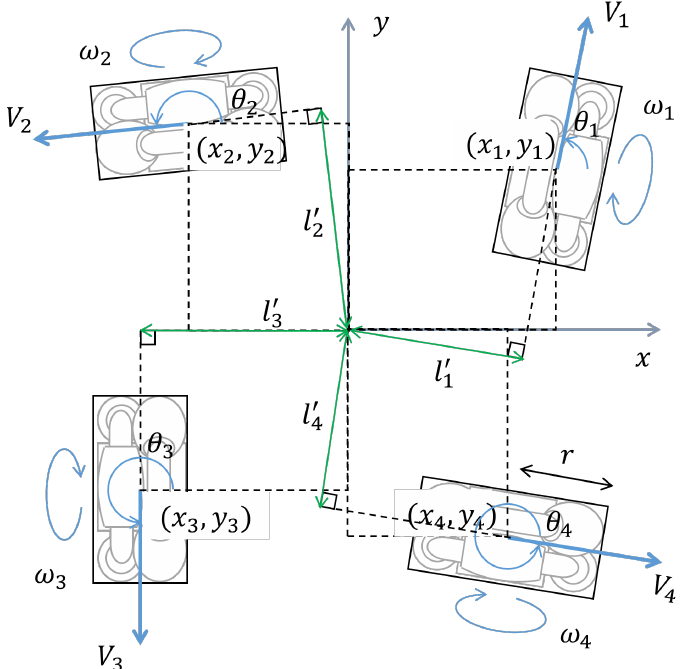
Figure 3. Pattern diagram of the Omni wheel robot: The parameters of each wheel of an Omni wheel robot are shown when a wheel of radius r is placed at position ( x , y ) and direction θ . ω and V are the rotational and ground speeds of the wheel, and l (cid:48) are the distance to the center of rotation of the robot relative to the velocity vector of each